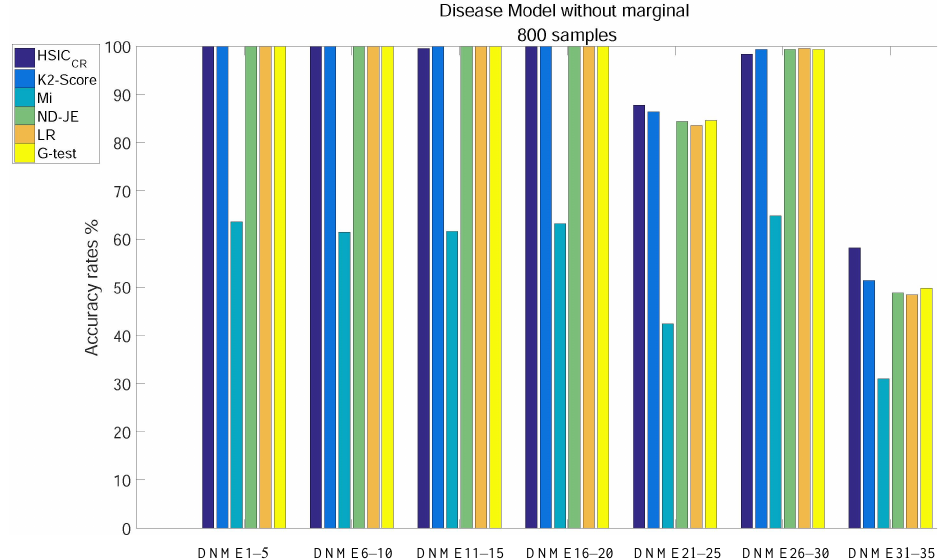
Figure 4. Disease model without marginal effects, with 800 samples and with k =